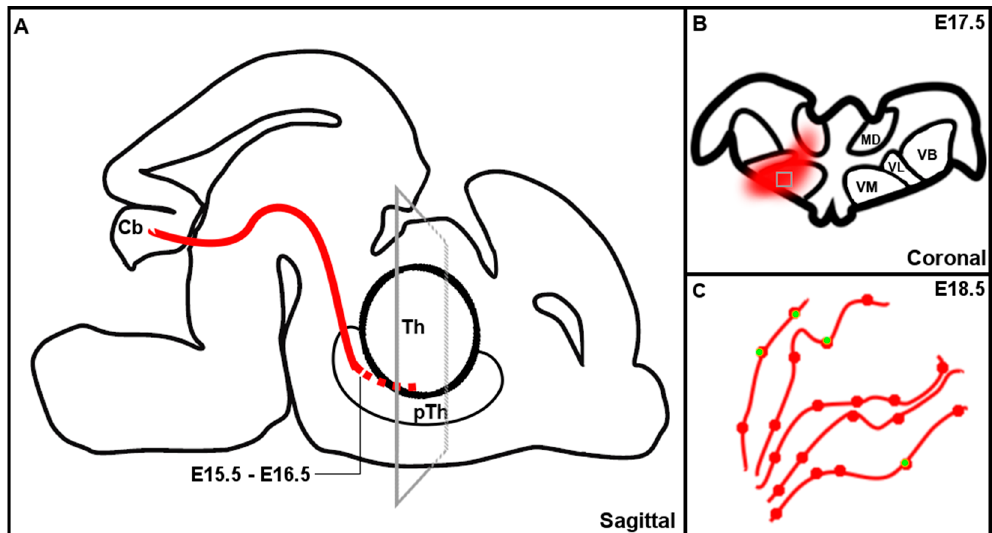
Figure 12. Schematic representation of the development of the cerebellothalamic tract. ( A ) Sagittal representation of the development of the cerebellothalamic tract (red). ( B ) Coronal representation of inset in A, showing schematic representation of the invasion of cerebellothalamic fibers (red) into the thalamus. ( C ) Zoom in of inset in ( B ), showing a schematic representation of the appearance of vGluT2 positive terminals (green) in the cerebellothalamic fibers (red) at E18.5. Th = thalamus, pTh = prethalamus, Cb = cerebellum, MD = mediodorsal nucleus, VB = ventrobasal nucleus, VL = ventrolateral nucleus, VM = ventromedial nucleus.